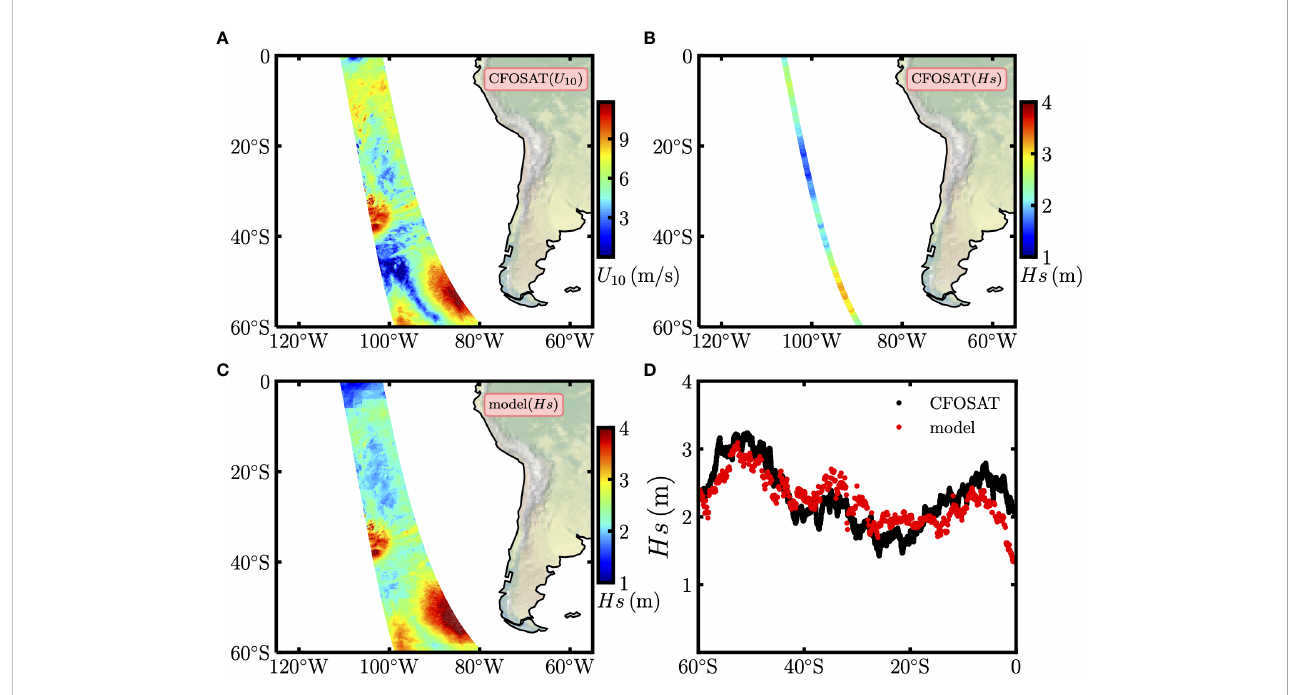
FIGURE 15 Simultaneously observed (A) U 10 and (B) Hs by the CFOSAT on January 16, 2022. (C) Wind-wave power-law model predicted Hs . (D) The meridional variations for CFOSAT along-track Hs (black dots) and the corresponding model predicted Hs (red